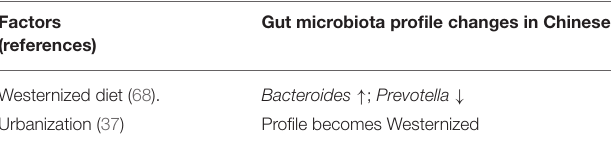
TABLE 4 | Industrialization, urbanization, and relevant environmental risk factors identified in Chinese